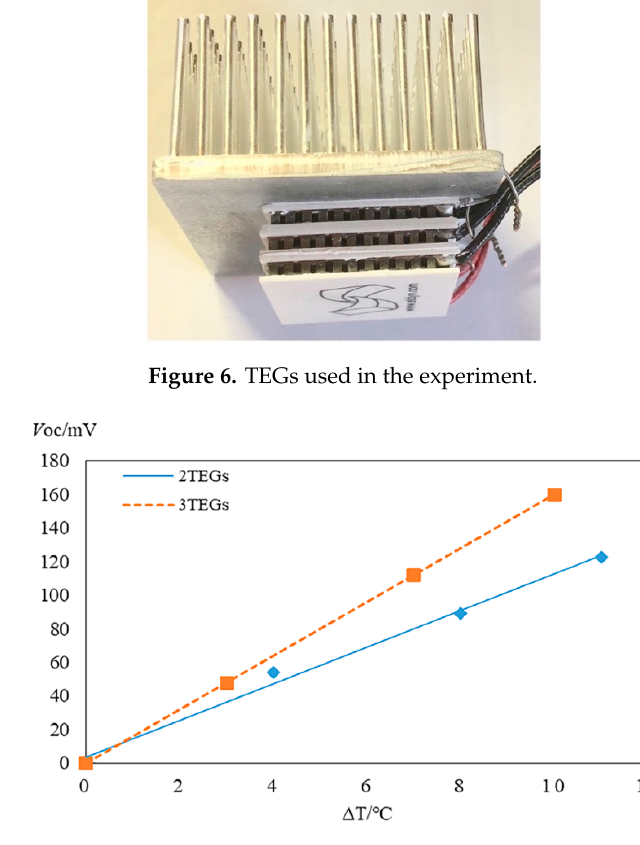
Figure 7. The relationship between the temperature di ff erence and open circuit voltage.